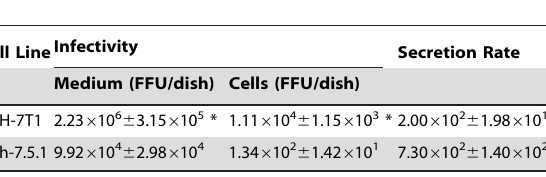
Cell Line Infectivity